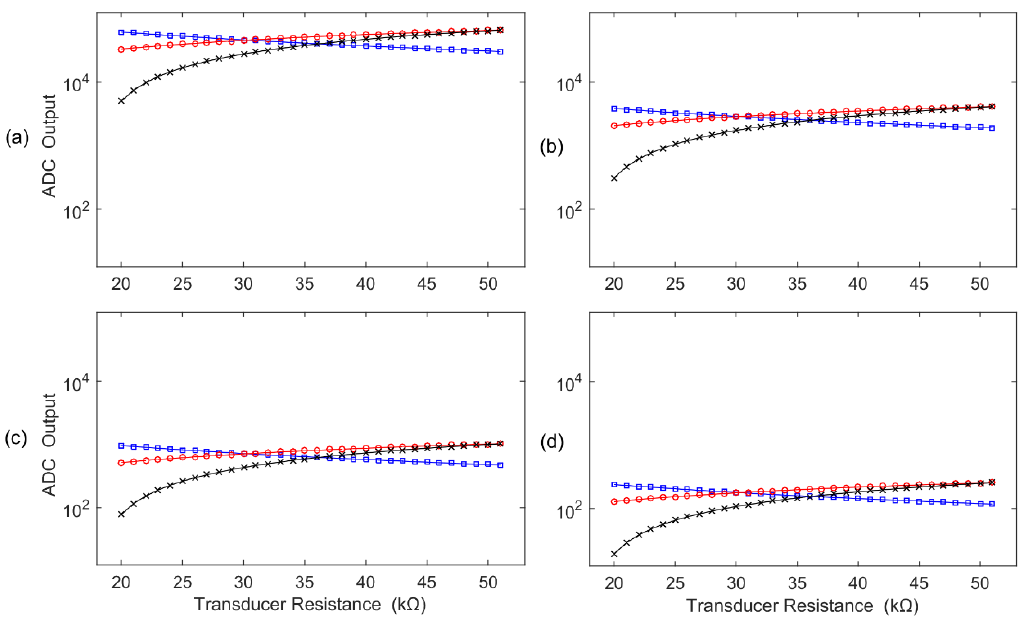
Figure 13. ADC output comparison among three grounding circuits: (1) × : classical bridge conversion circuit; (2 ) □ : fixed resistor grounding bleeder circuit; (3 ) ο : transducer grounding bleeder circuit. The results correspond to the ( a ) 16-bit ADC, ( b ) 12-bit ADC, ( c ) 10-bit ADC, and ( d ) 8-bit ADC. Table 1. Comparison of the three circuits.